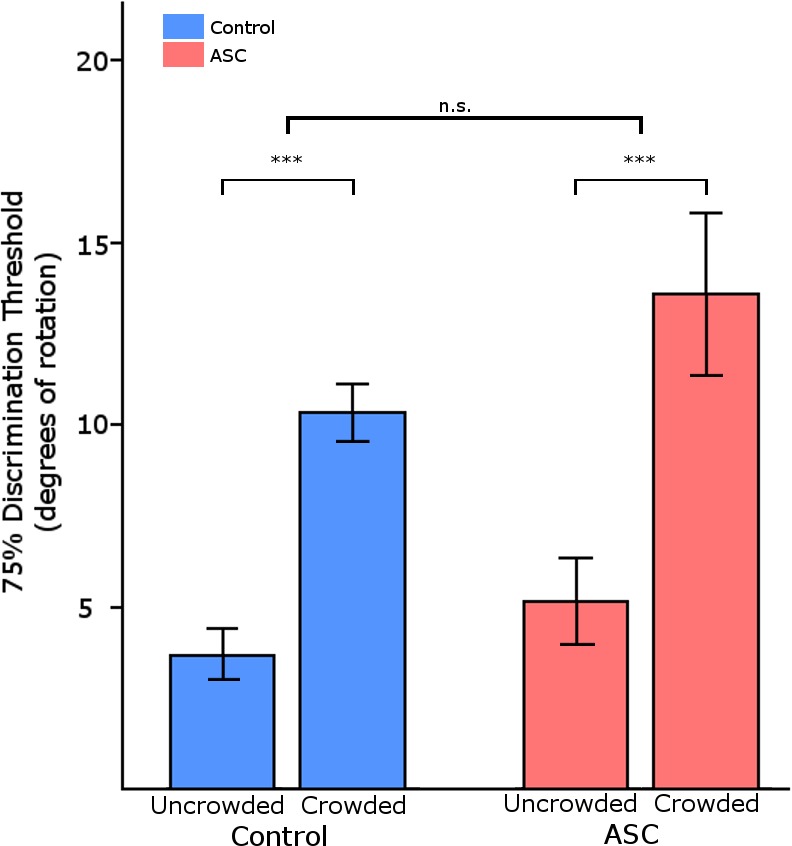
75% discrimination thresholds in Experiment 1 (Uncrowded) and 2 (Crowded). Error bars represent one standard error of the mean. The crowding effect was significant in both groups (***, p < 0.001). This effect was equally strong in both groups, and there were no group differences overall.